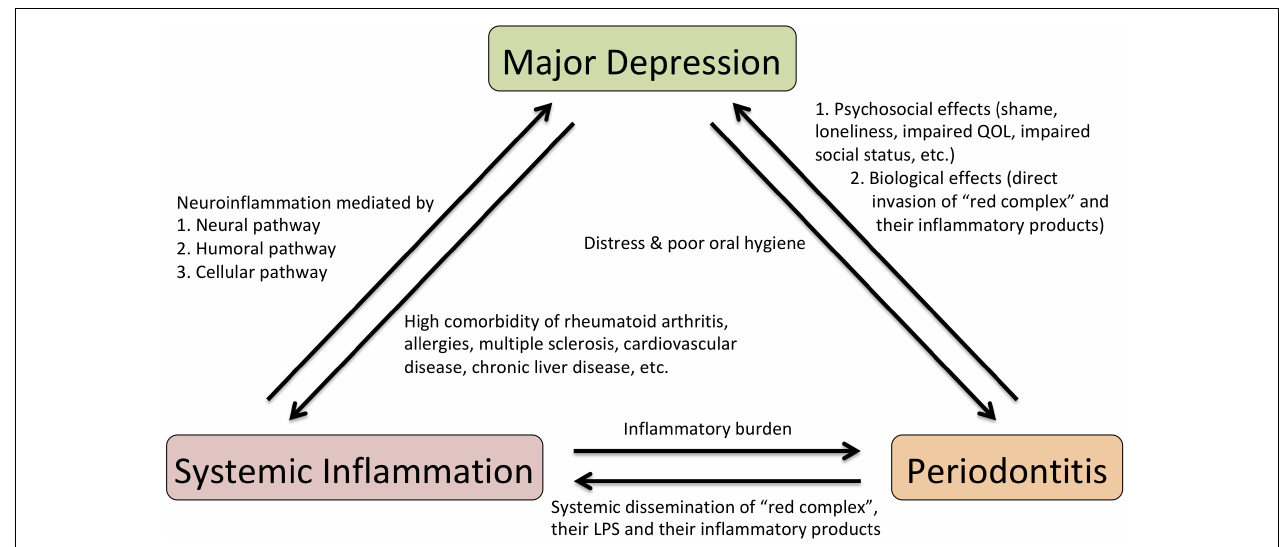
FIGURE 1 | Scheme for presumed mechanisms of reciprocal connection between systemic inflammation, periodontitis and major depression. LPS, lipopolysaccharide; QOL, quality of